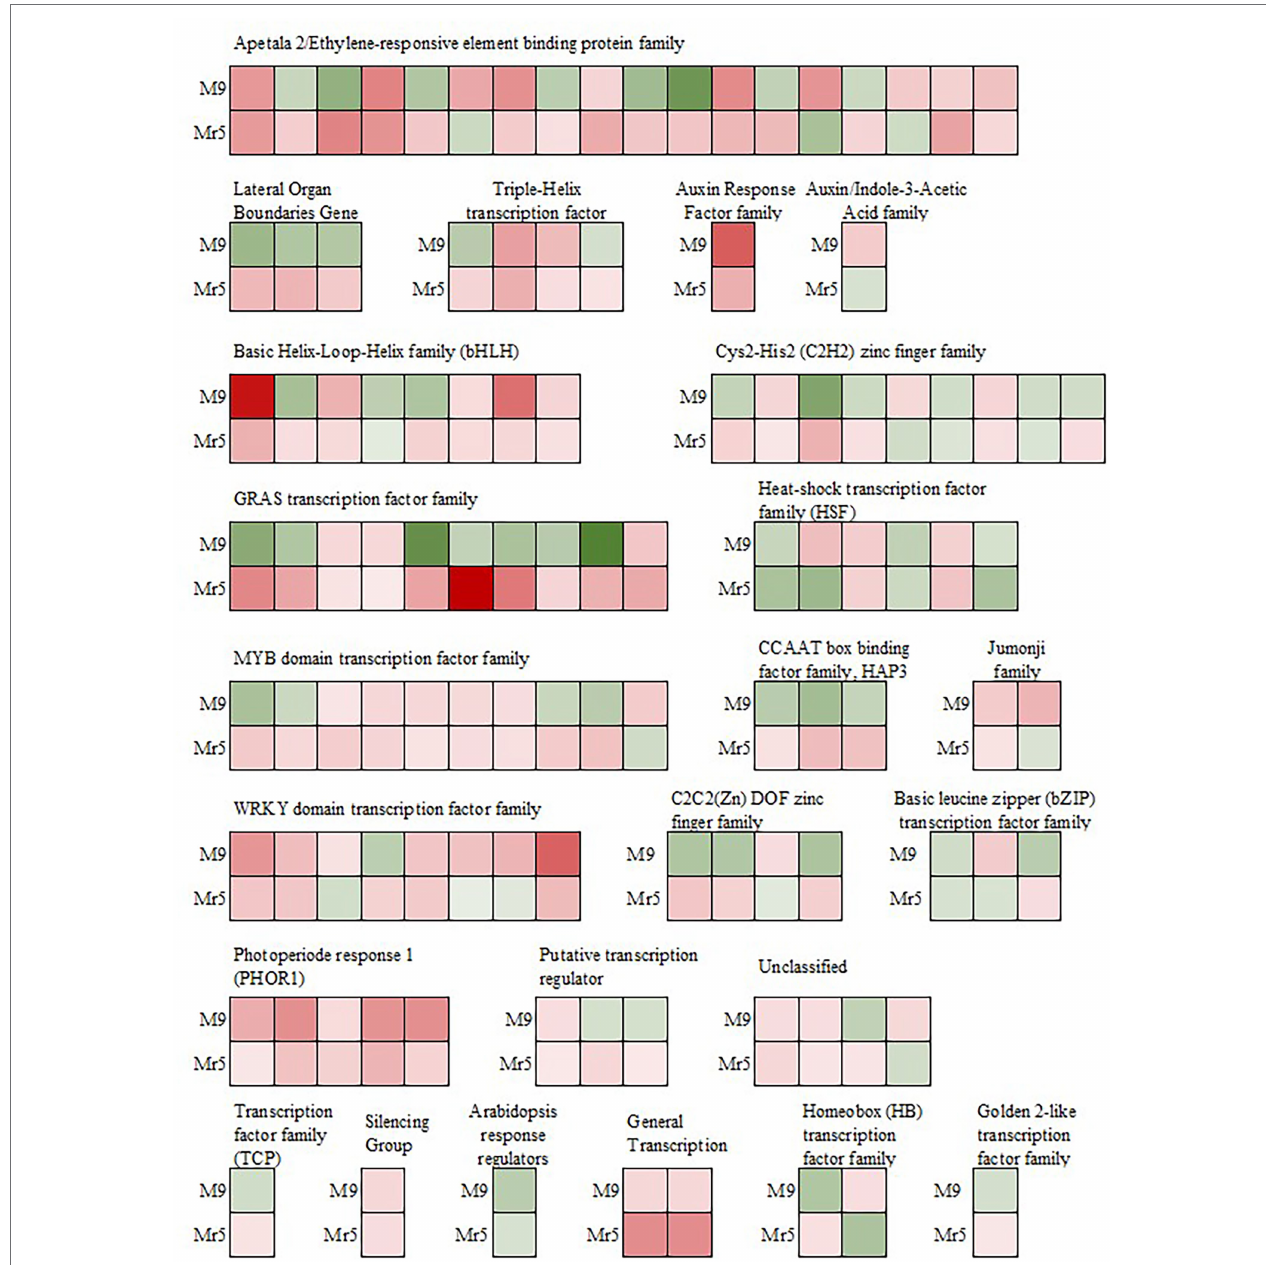
FIGURE 5 | Expression of genes encoding transcription factors after induction of ARD in the susceptible rootstock ‘M9’ and the ARD tolerant wild apple cultivar M. × robusta 5 (Mr5) within the 1,206 DEGs. Green indicates downregulation, whereas red indicates upregulation in ARD soil. The intensity of the color represents the level of gene expression. GRAS: named after the first three transcription factors, namely, GAI (Gibberellic Acid Insensitive), RGA (Repressor of Gai) and SCR (Scarecrow); MYB : Avian myeloblastosis virus; CCAAT box : distinct pattern of nucleotides with GGCCAATCT consensus sequence; HAP3 : Heme Activator Protein3; WRKY : named after the WRKYGQK heptapeptide at the N-terminal end; C2C2(Zn) DOF : family of DNA binding with one C2C2-type zinc finger motif at the